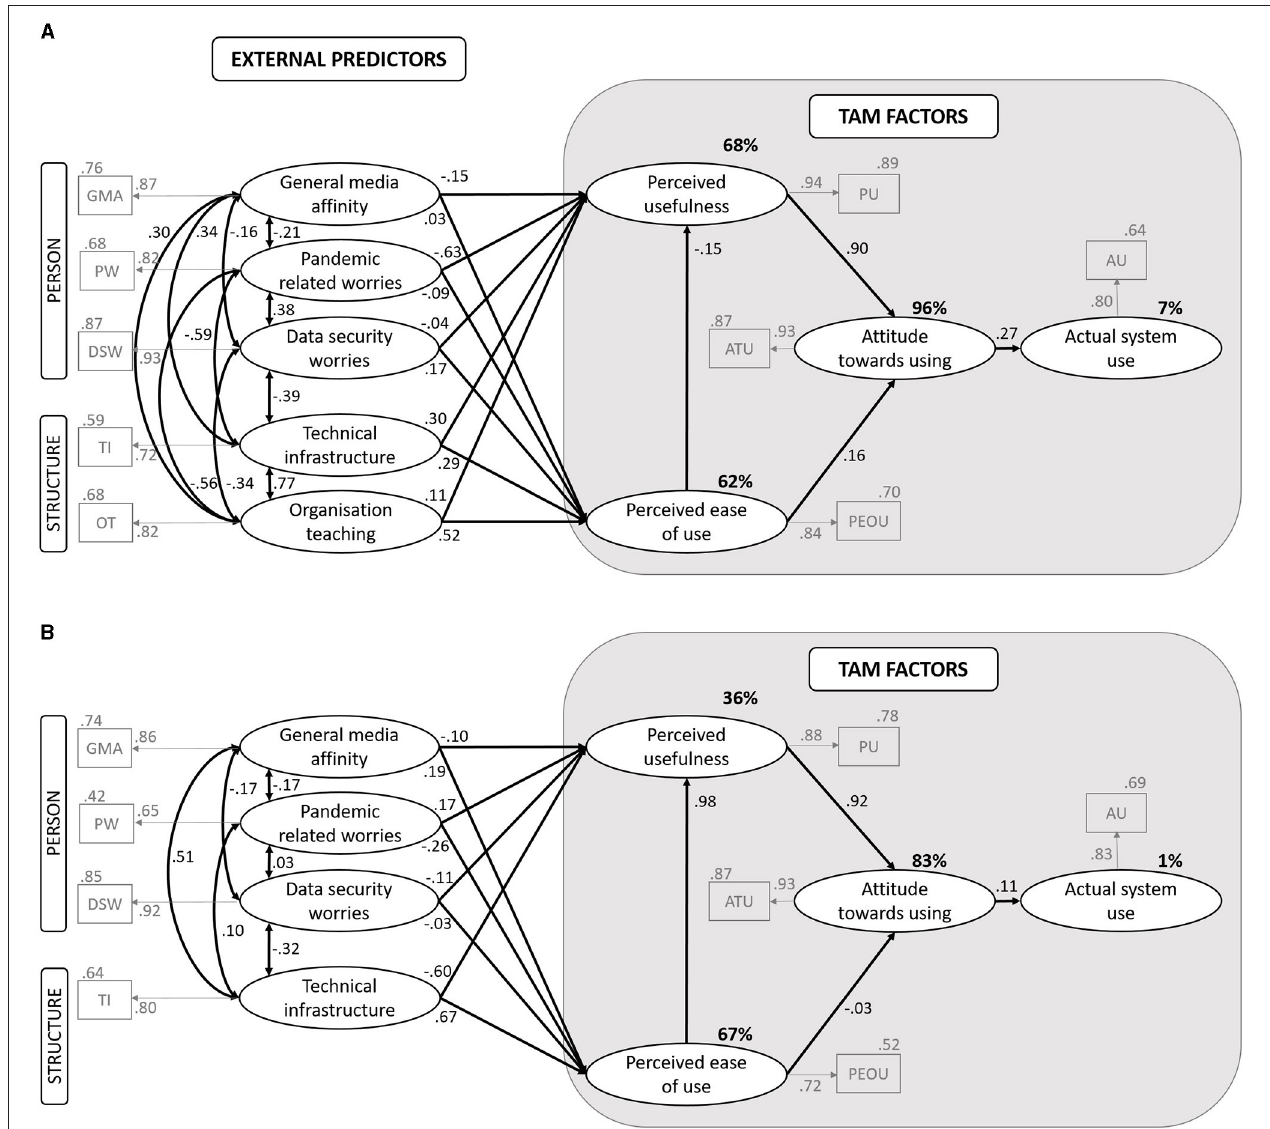
FIGURE 1 | Latent structural path models. (A) Students. (B) Lecturers. Rectangles indicate observed indicator variables. Ovals indicate latent variables. Numbers on arrows indicate standardized regression